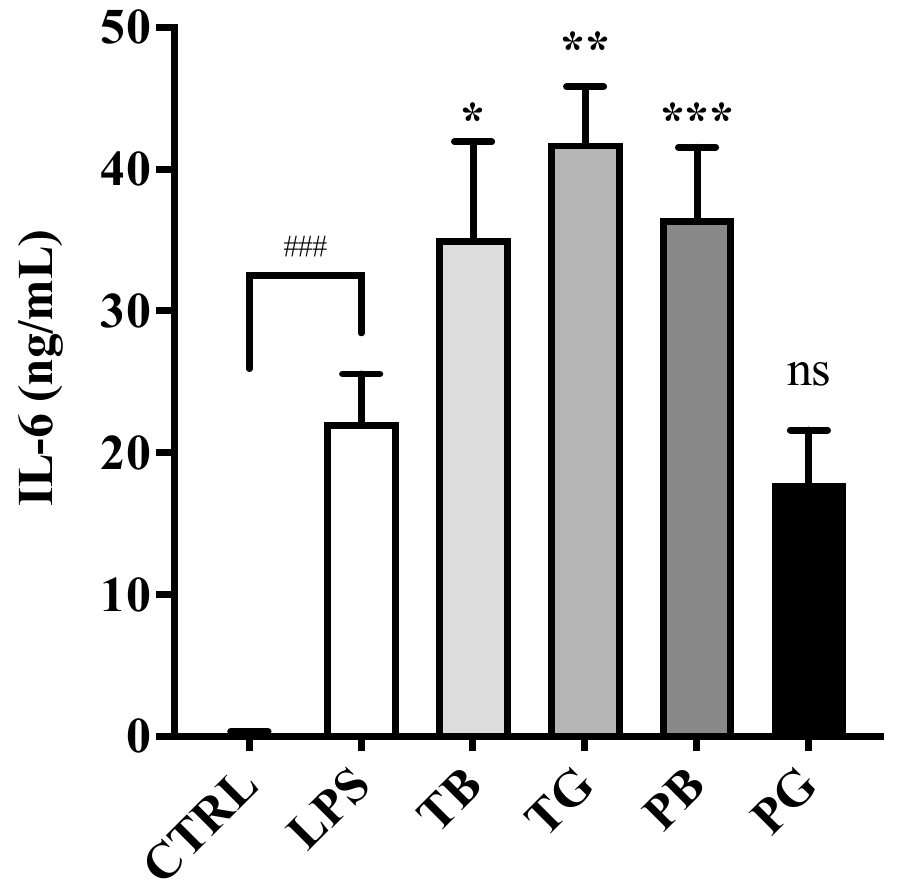
Figure 7. Effects of various tea pretreatment on IL-6 secretion in LPS-stimulated macrophages as the inflammatory model. LPS (0.5 µ g/mL) was added to all groups at time 0 h for 24 h until assay, except the control group. In the LPS-stimulated macrophages, the cells were incubated in the medium without/with tea samples (0.5 mg/mL). The data were presented as mean ± SE of three experiments. * p < 0.05; ** p < 0.01; *** p < 0.001, and ns p > 0.05 vs. LPS group and ### p < 0.001 vs. control. IL-6: Interleukin-6; LPS: lipopolysaccharide; T: Taiwan Tea Experiment Station No. 12; P: purple shoot tea; G: green tea and B: black tea.